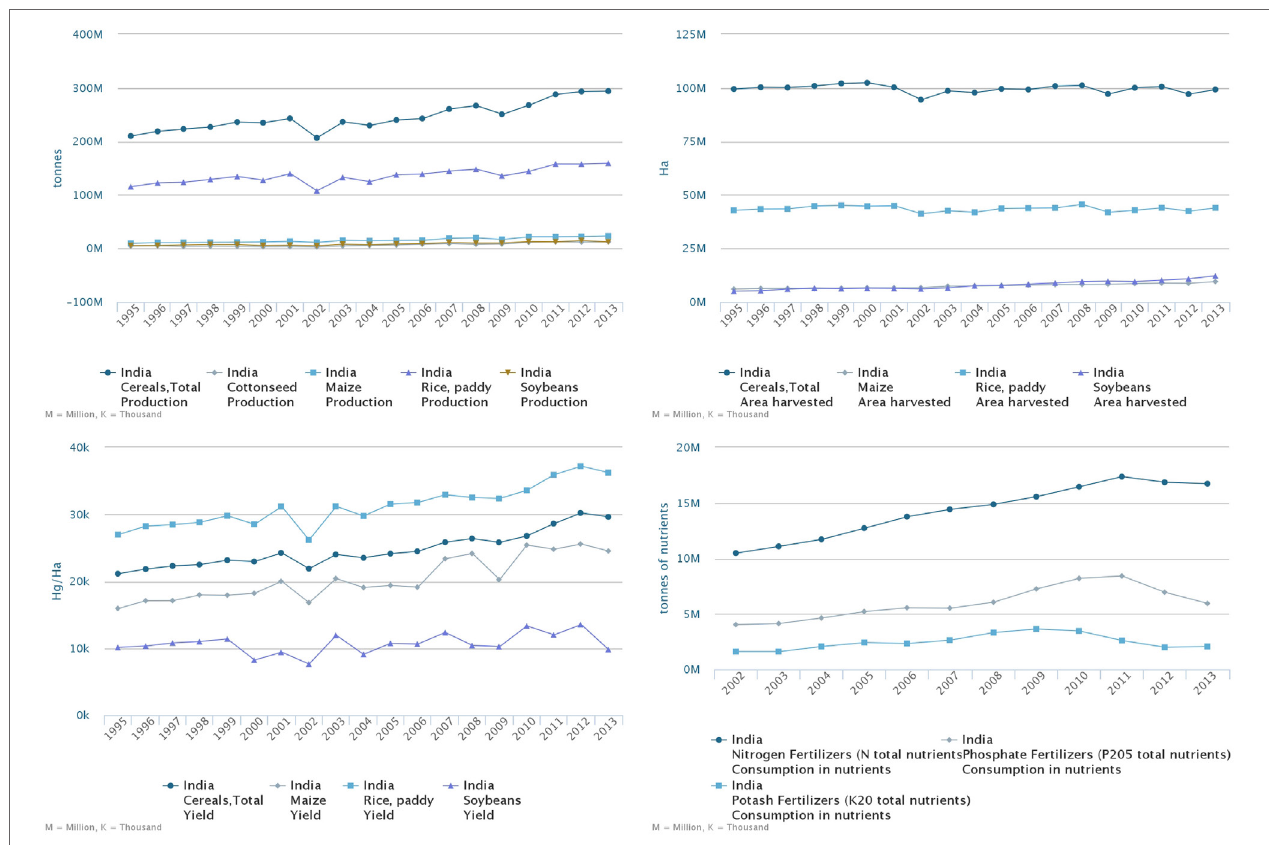
FigUre 2 | India’s cereals production (top left panel), harvested areas (top right panel), crop yields (bottom left panel), and fertilizer use (bottom right panel). Source: